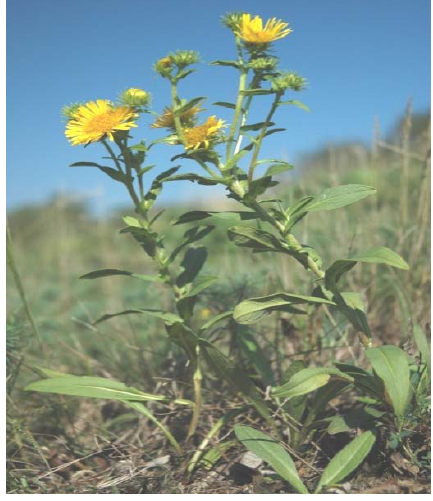
Figure 1. Inula britannica (courtesy Mr. Ivan Bilek, Nature